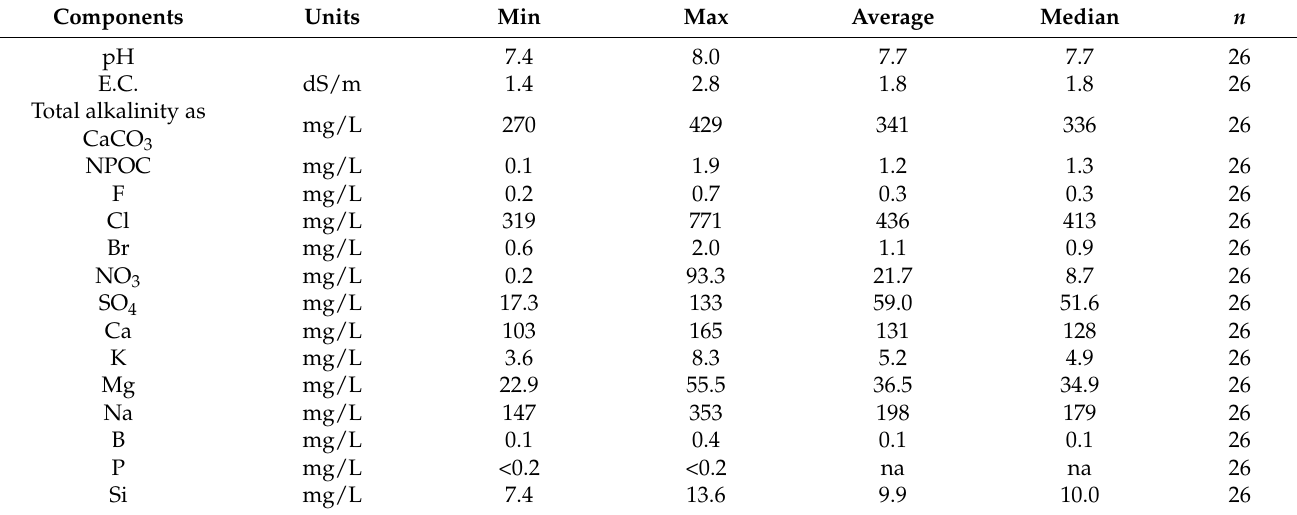
Table A1. Overview of the inorganic groundwater